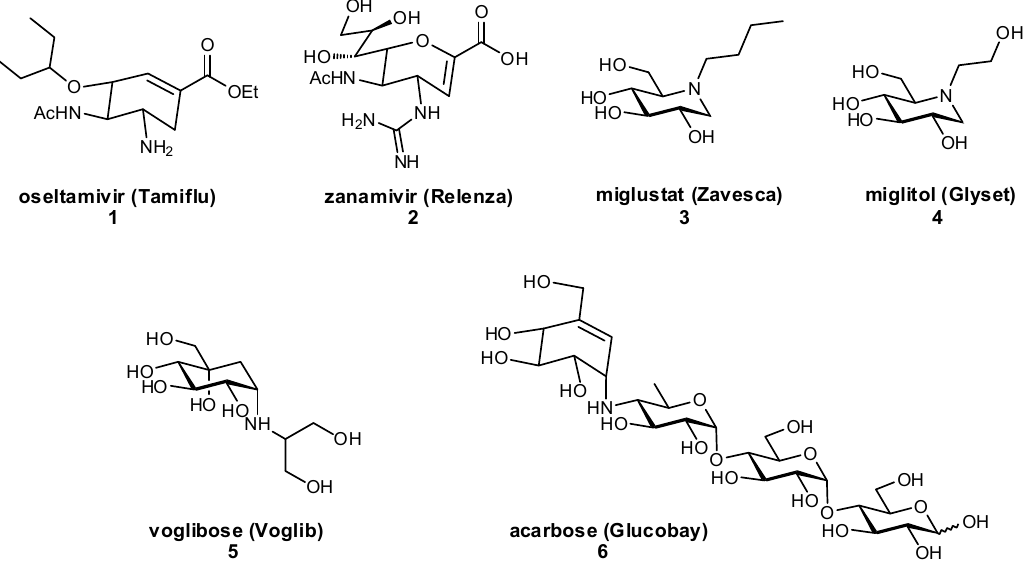
Figure 2. Examples of glycomimetic inhibitors that have successfully reached the market.